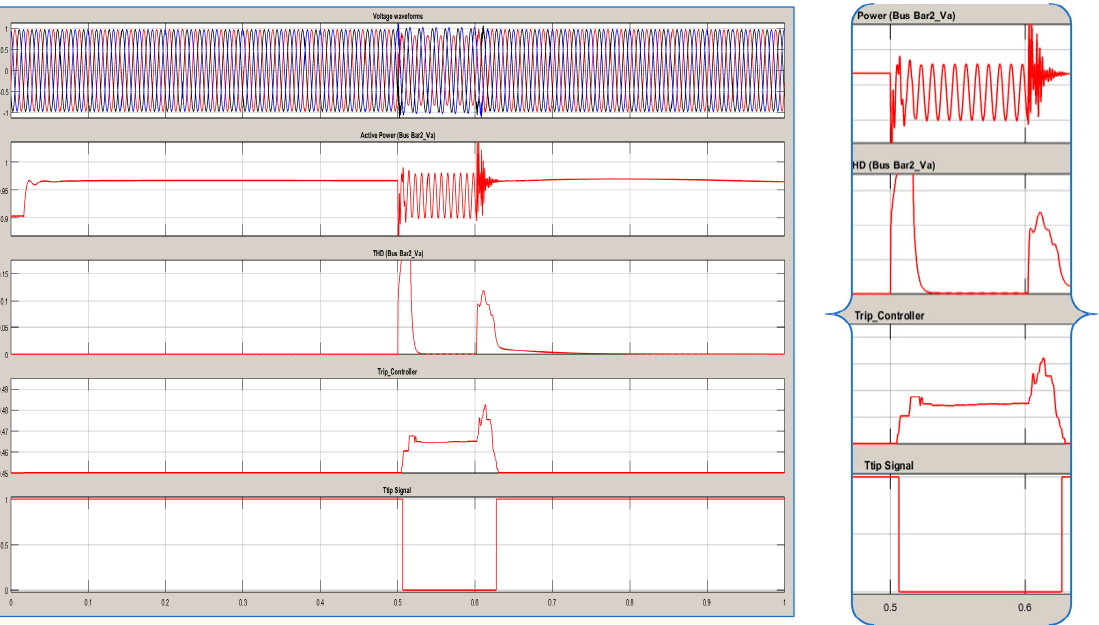
Figure 15. Double line (AB_G) fault voltage waveform.